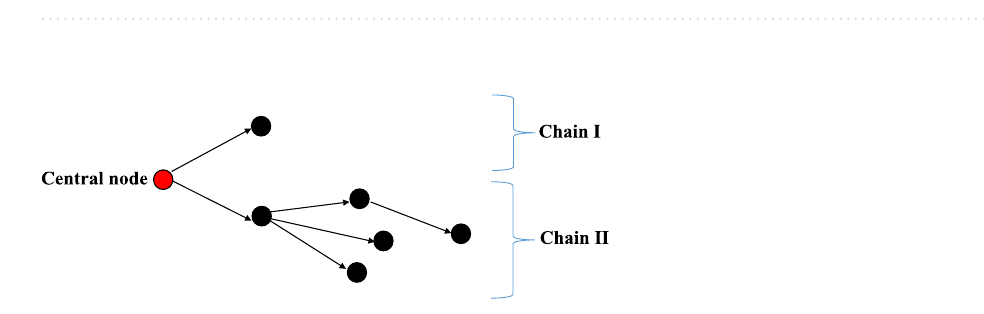
Table 3. The detailed description of 5 indexes applied for assessing the evolving epidemiology of COVID-19.